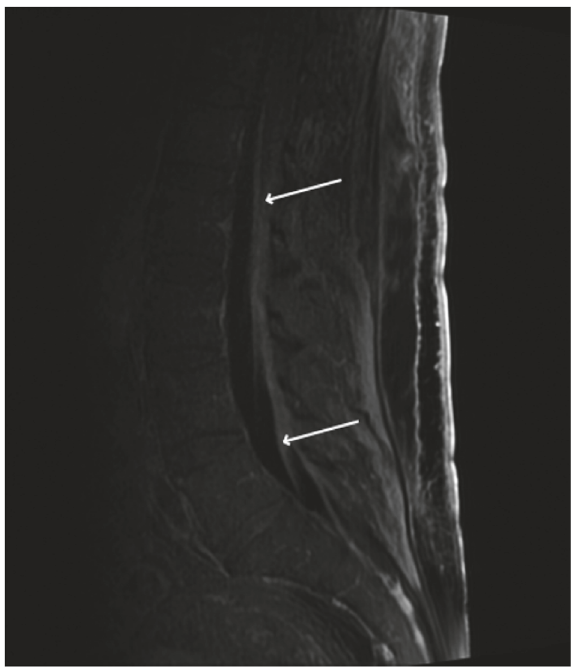
Figure 1: Sagittal view of MR lumbar spine T1 FLAIR depicting significant leptomeningeal enhancement and thickening of nerve roots